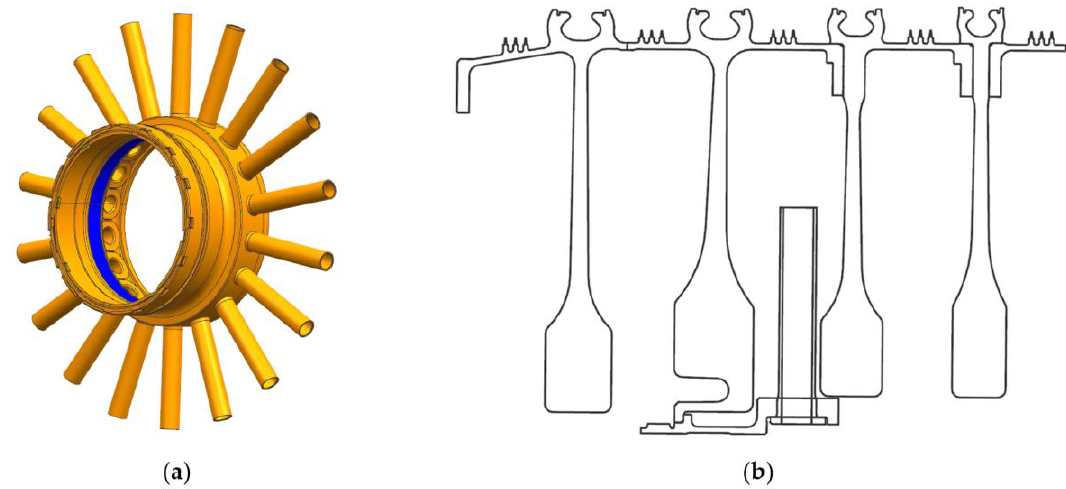
Figure 2. Vortex reducer and its installation position: ( a ) Three dimensional model; ( b ) Position diagram.